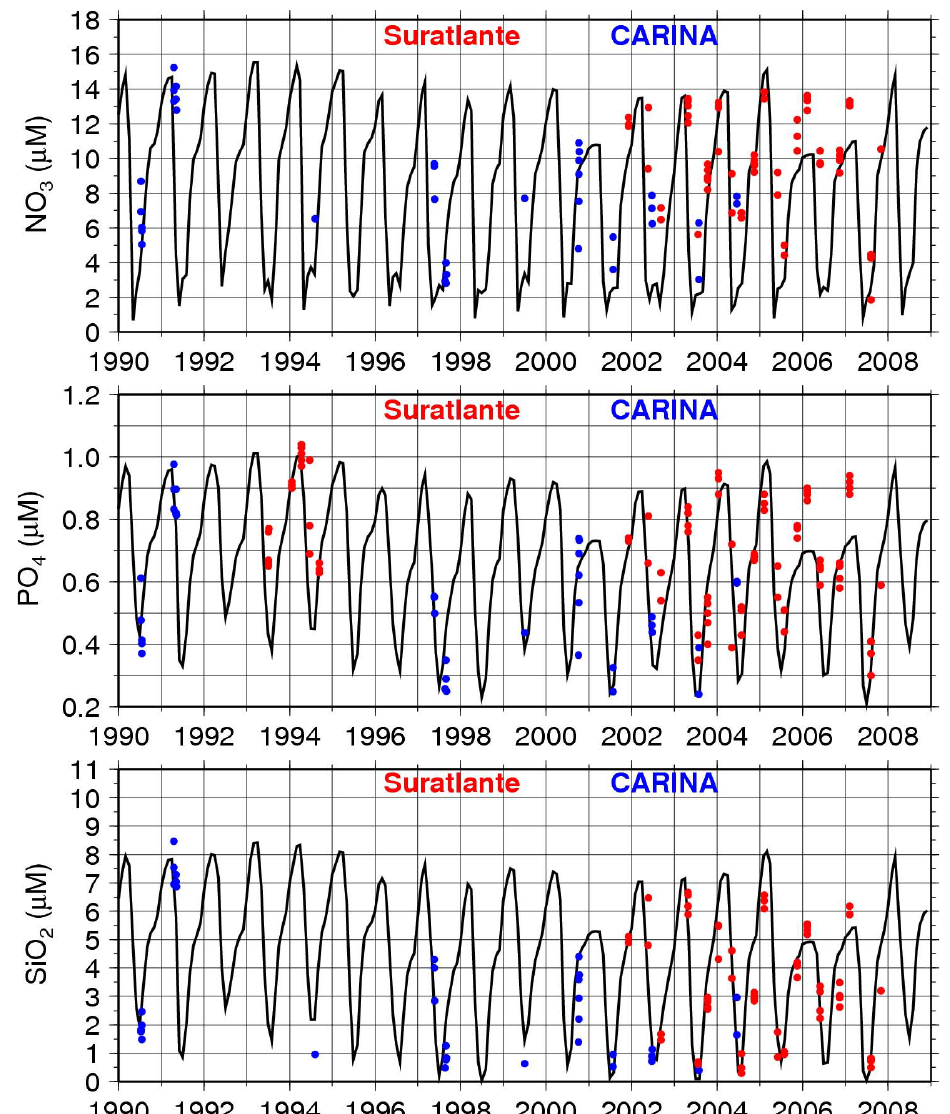
Fig. 9. Time series of model surface nutrients (NO 3 , PO 4 , SiO 2 ) with corresponding in situ observations from Suratlante (red dots) and CARINA (blue